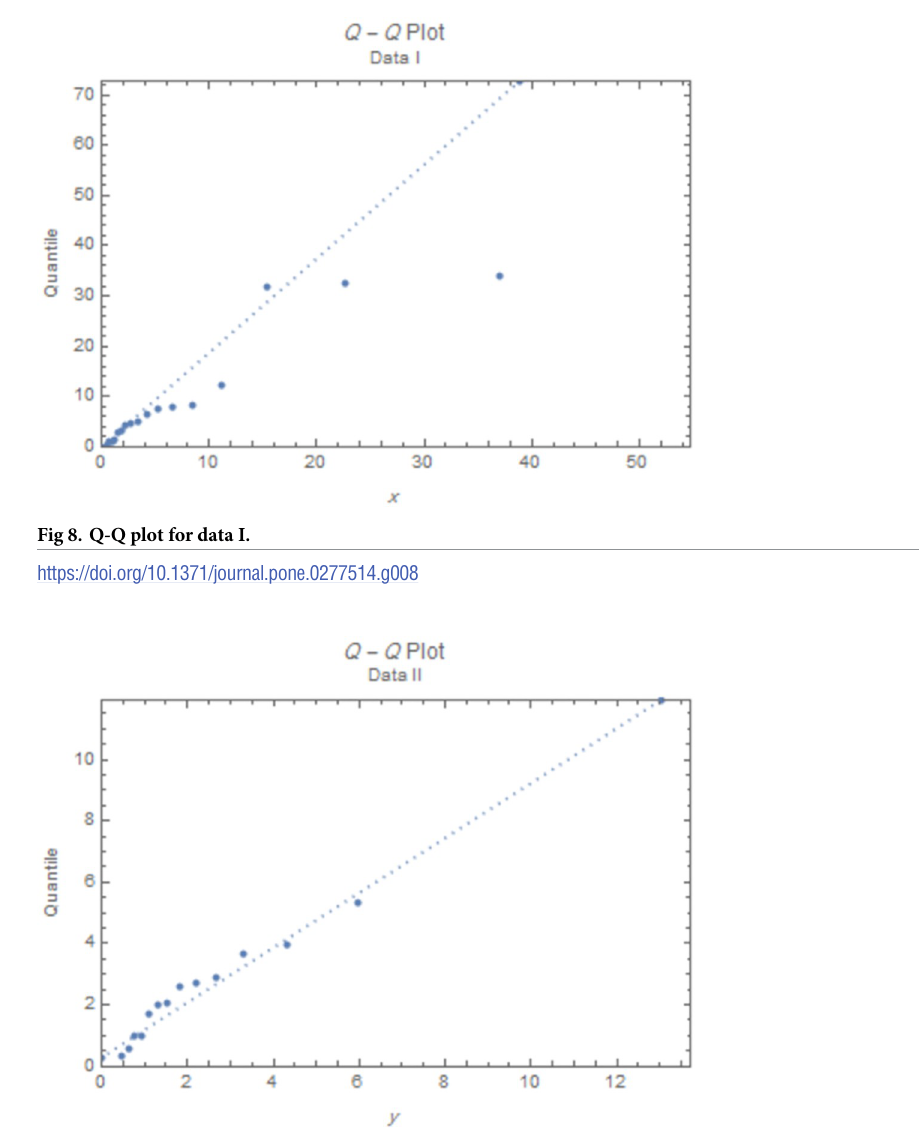
Fig 9. Q-Q plot for data II.